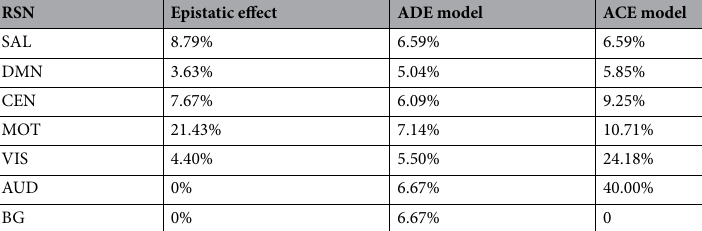
Table 5. Percentage of resting state network connections affected by epistatic effects or genetic and environmental influences expressed by ACE or ADE twin models. SAL, salience network; DMN, Default mode network; CEN, central executive network; MOT, sensorimotor network; VIS, visual network; AUD, auditory network; BG, basal ganglia network; RSN, Resting state